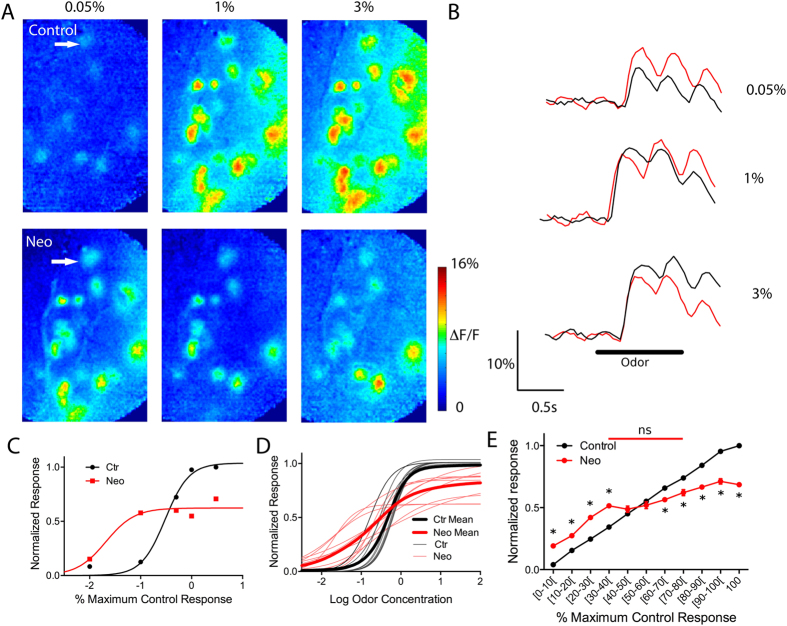
Neostigmine bidirectionally modulates glomerular odor responses.(A) 10× magnification images of responses to increasing concentrations of 2 heptanone in control condition (top) and during neostigmine (Neo) application (bottom). Glomerular odor responses are increased after neostigmine application for the low concentration, they remain unchanged at the middle range concentration and are decreased at the high concentration. (B) Fluorescence signal traces for the selected glomerulus shown in A showing response increase (for all the 0.05% concentration), no change (1.0%) or decrease (3%). (C) Example of a sigmoid fit of Log odor concentration- normalized odor responses curves in control and during neostigmine application. Neostigmine shifts the curve to the left resulting on decreasing the EC50 and also decreases the maximum response. (D) Sigmoid fit of Log odor concentration – normalized odor responses of all the glomeruli shown in A, the thick lines show the average curves in both control (black) and neostigmine (red) conditions. The grey and red curves are individual curves of each responsive glomerulus before and during neostigmine application. (E) Population normalized control and post-neostigmine curves, plotted as function of the normalized control responses divided into 10% intervals. The curves show that odor responses are increased by neostigmine from the [0–40%] intervals, are unchanged around 50% causing the post-neostigmine curve to cross the control curve at this point, and responses are significantly decreased in the [60–100%] intervals. *p < 0.01, ns: p > 0.05). Red bar: post-neostigmine responses are not significant from each other within the [30–80%[interval.